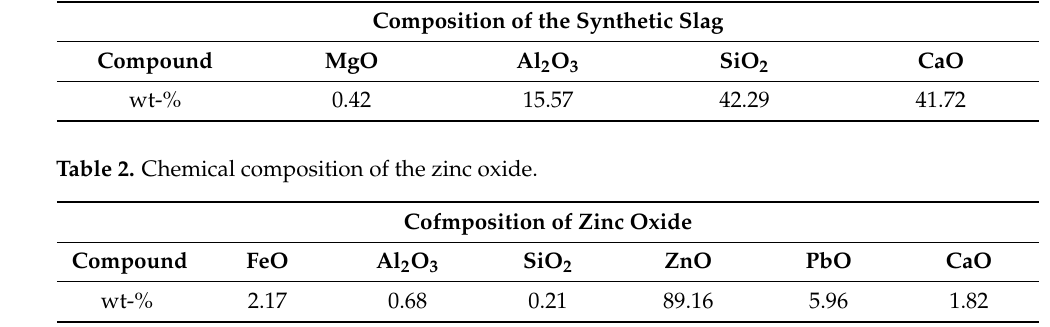
Table 1. Chemical composition of the synthetic slag.